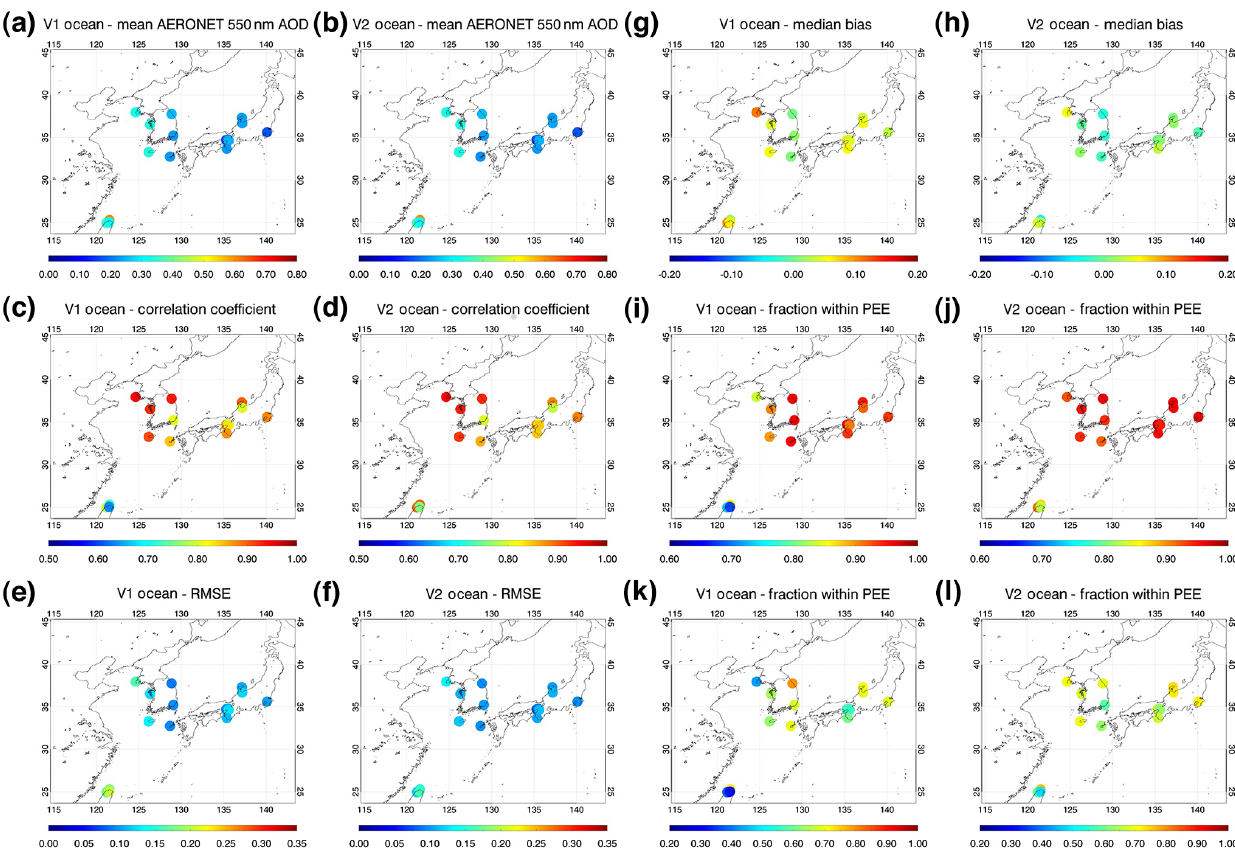
Figure 13. As for Fig. 12, except for GOCI ocean